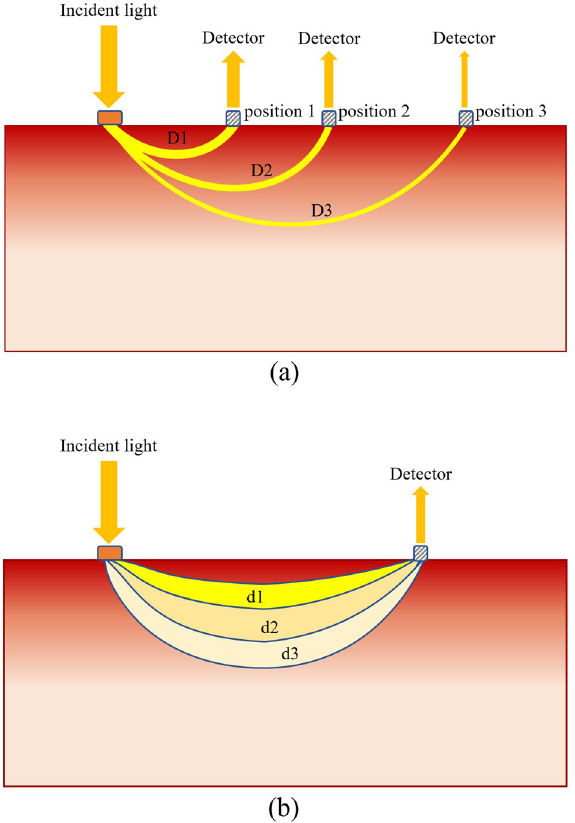
Figure 1. Graphical illustration of the pathways of light and their intensities in fruit flesh. ( a ) The light has a longer path length, and its intensity becomes weaker as it reaches farther away from the light source; ( b ) The light has a longer path length as it reaches greater depths, showing a banana-shaped path. Mechanism of multiple detectors at different positions on samples might acquire information needed for analysis of internal properties of fruit flesh at different